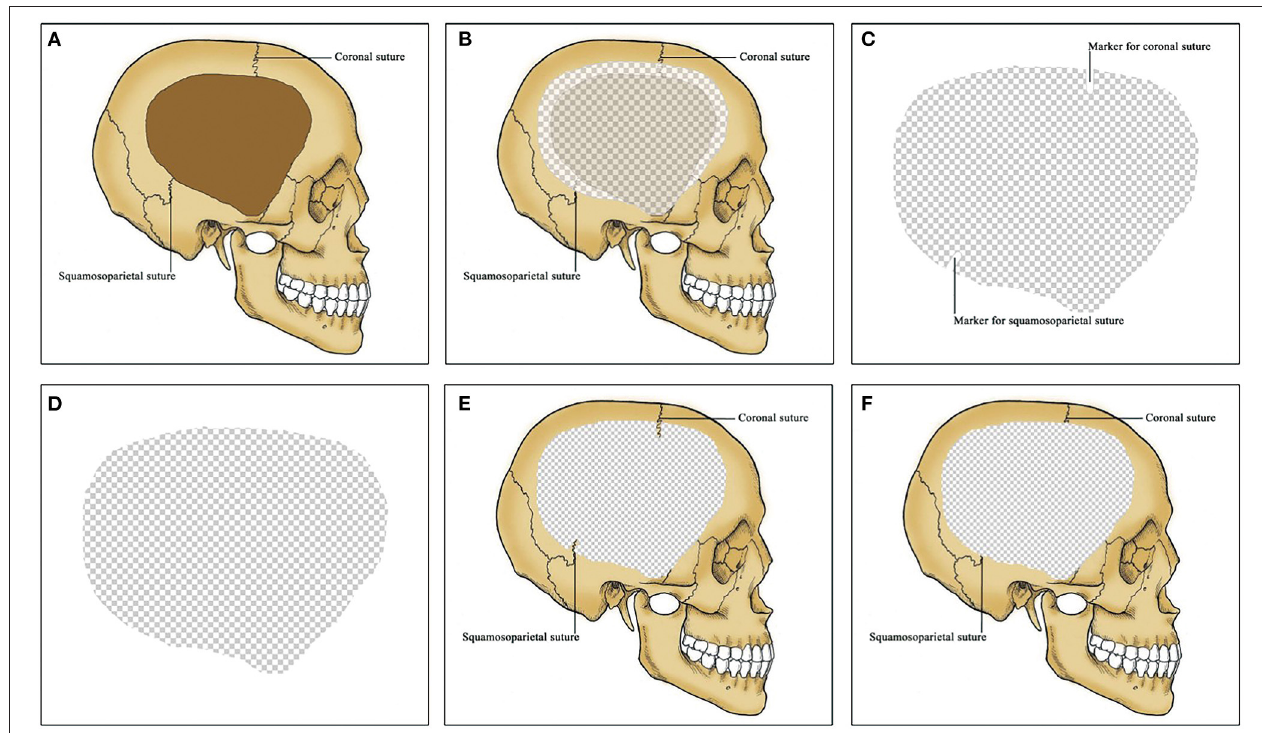
FIGURE 2 | 3D titanium mesh for cranioplasty (CP). (A) A unilateral frontotemporoparietal skull defect. Coronal and squamosoparietal sutures are observed in the skull. (B) CP using 3D titanium mesh. Titanium mesh exceed the skull defect by about 1cm except for the middle fossa. (C) titanium mesh for patients in the intervention group. Coronal and squamosoparietal sutures are marked in the titanium mesh by obvious indentations as anatomical positioning markers. (D) titanium mesh for patients in the control group. No anatomical positioning markers in the titanium mesh. (E) Titanium cranioplasty (Ti-CP) in the intervention group. The anatomical positioning markers are matched with the coronal and squamosoparietal sutures respectively. (F) Ti-CP in the control group. 3D, three-dimensional; CP, cranioplasty; Ti-CP, titanium